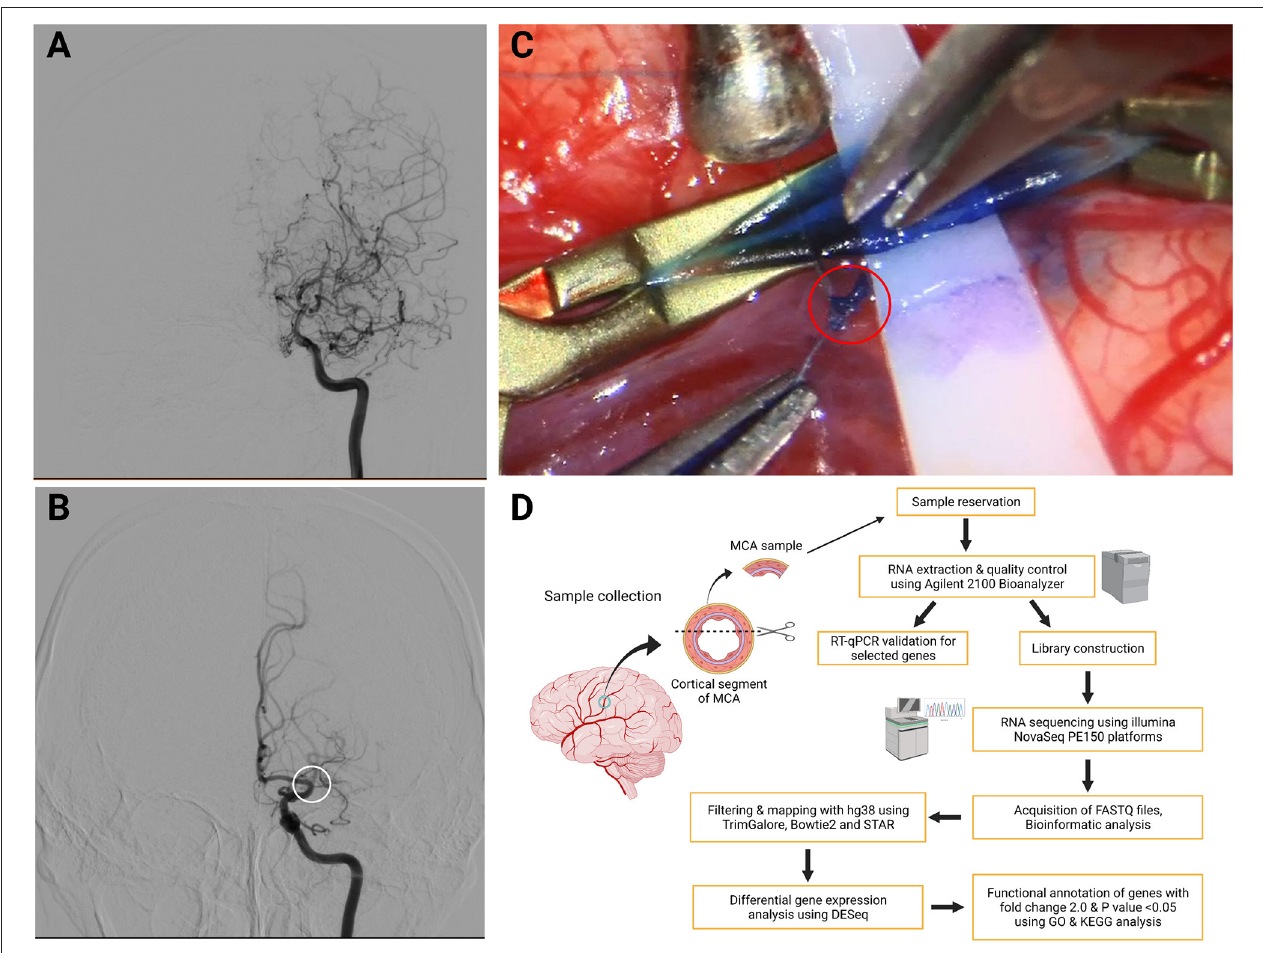
FIGURE 1 | Typical digital subtraction angiography (DSA) images for diagnosis, intraoperative image of obtaining middle cerebral artery (MCA) specimens, and workflow diagram of this study. (A) Typical image of Moyamoya disease (MMD). It shows stenosis-occlusion in the left terminal portion of the internal carotid arteries (ICAs) and the proximal segment of anterior cerebral artery (ACA) and MCA accompanied by moyamoya vessels. (B) Typical image of atherosclerosis-associated intracranial artery stenosis/occlusion (AS-ICASO). It shows the left M1 segment of MCA occlusion (white circle) without moyamoya vessels. (C) Arteriotomy was performed cautiously with microscissors, and a tiny piece of specimen was harvested from the artery in the red circle. (D) Workflow diagram of this study. Created with BioRender.com